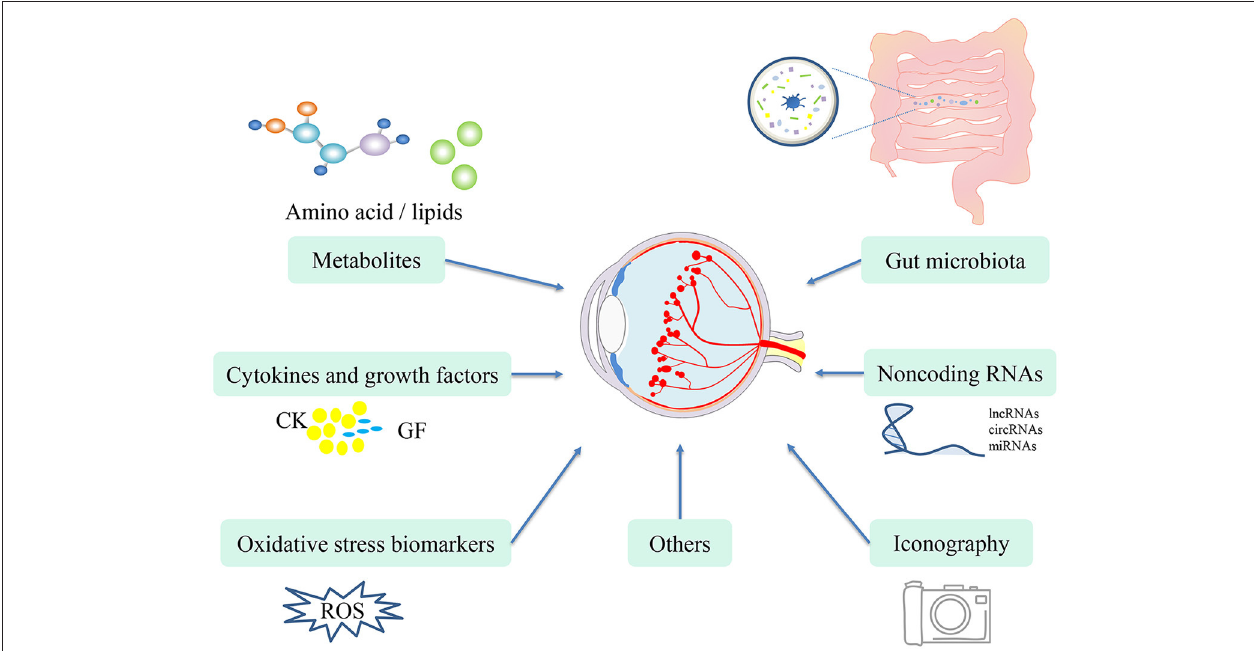
FIGURE 1 | Novel potential biomarkers for ROP, including metabolites, cytokines and growth factors, ncRNAs, iconography, gut microbiota, oxidative stress biomarkers and others.